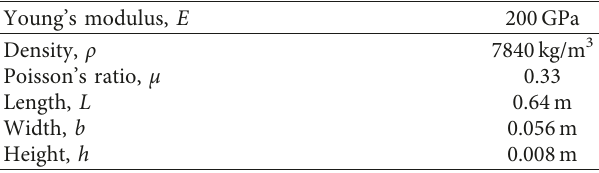
Figure 7: Experimental system of cantilever beam: (a) impact load and (b) harmonic load. Table 3: Parameters of the cantilever